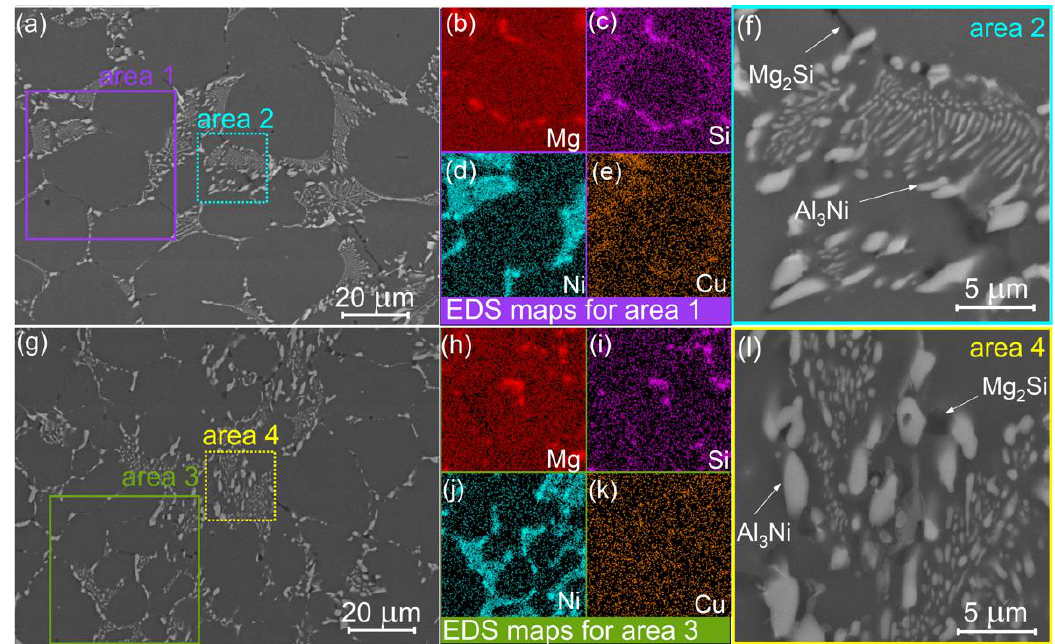
Figure 5. SEM images for the alloy 3 (Al-1.2Mg-0.7Si-1.0Cu-4Ni) after ( a – f ) one step homogenization at 350 °C, 8 h and ( g – l ) two-step with the first step at 350 °C, 8 h and second step at 480 °C, 3 h; ( b – e ) and ( h – k ) are the EDS maps captured from the are marked up with red square in ( a ) and green square in ( g ), respectively; ( f ) and ( l ) are the magnified areas marked up with blue square in ( a ) and yellow square in ( g ), respectively.